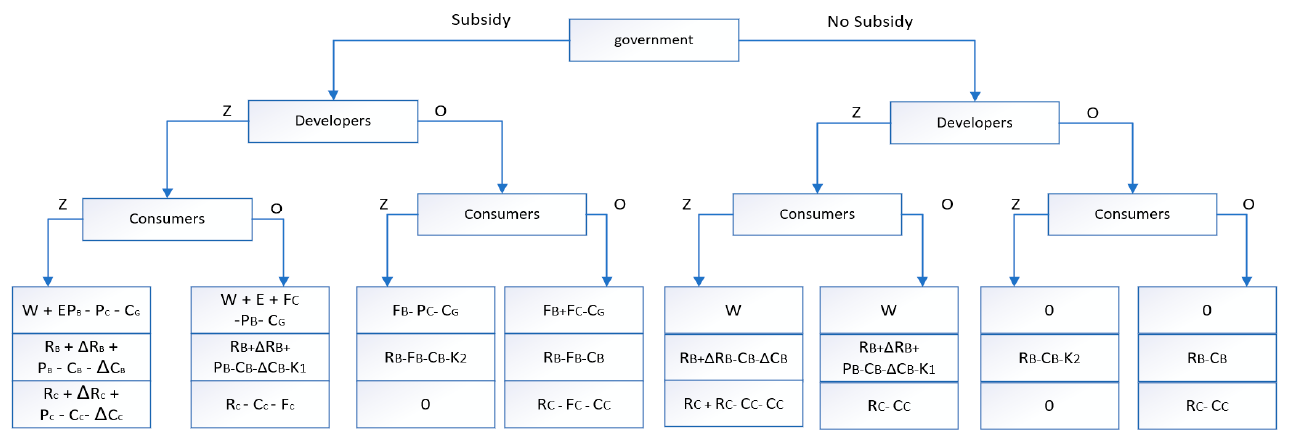
Figure 1. The expected return free diagram.